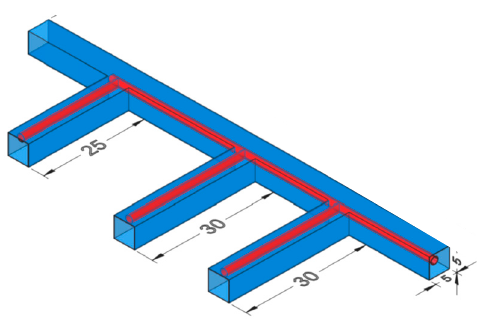
Figure 2. Drift system